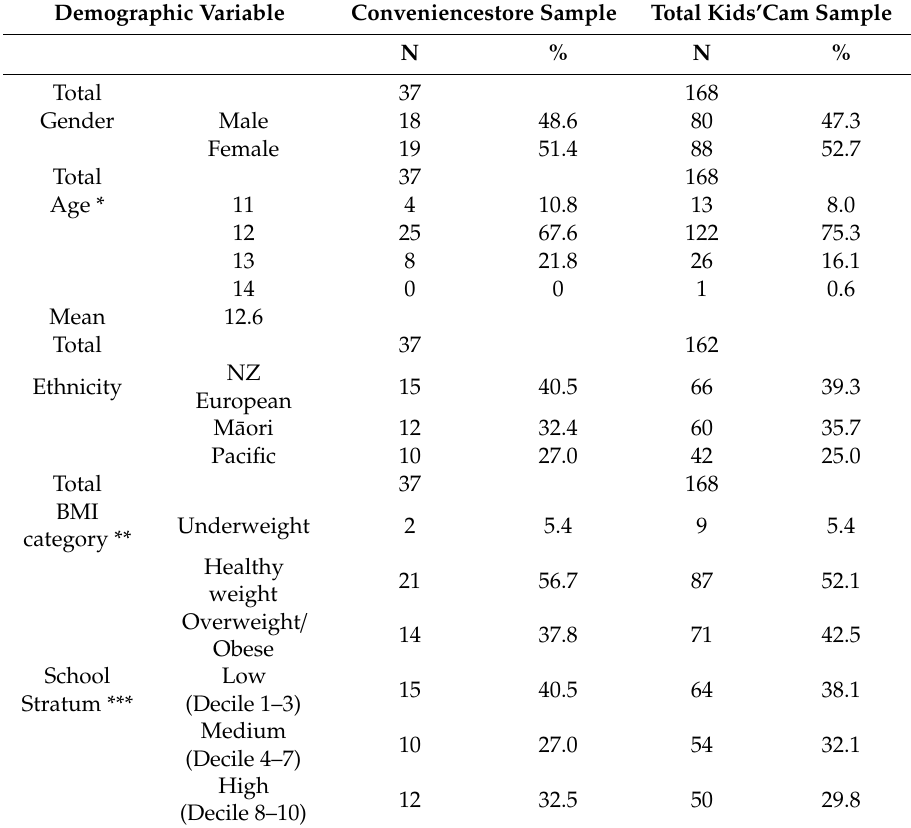
Table 2. Demographic characteristics of the Kids’Cam convenience store